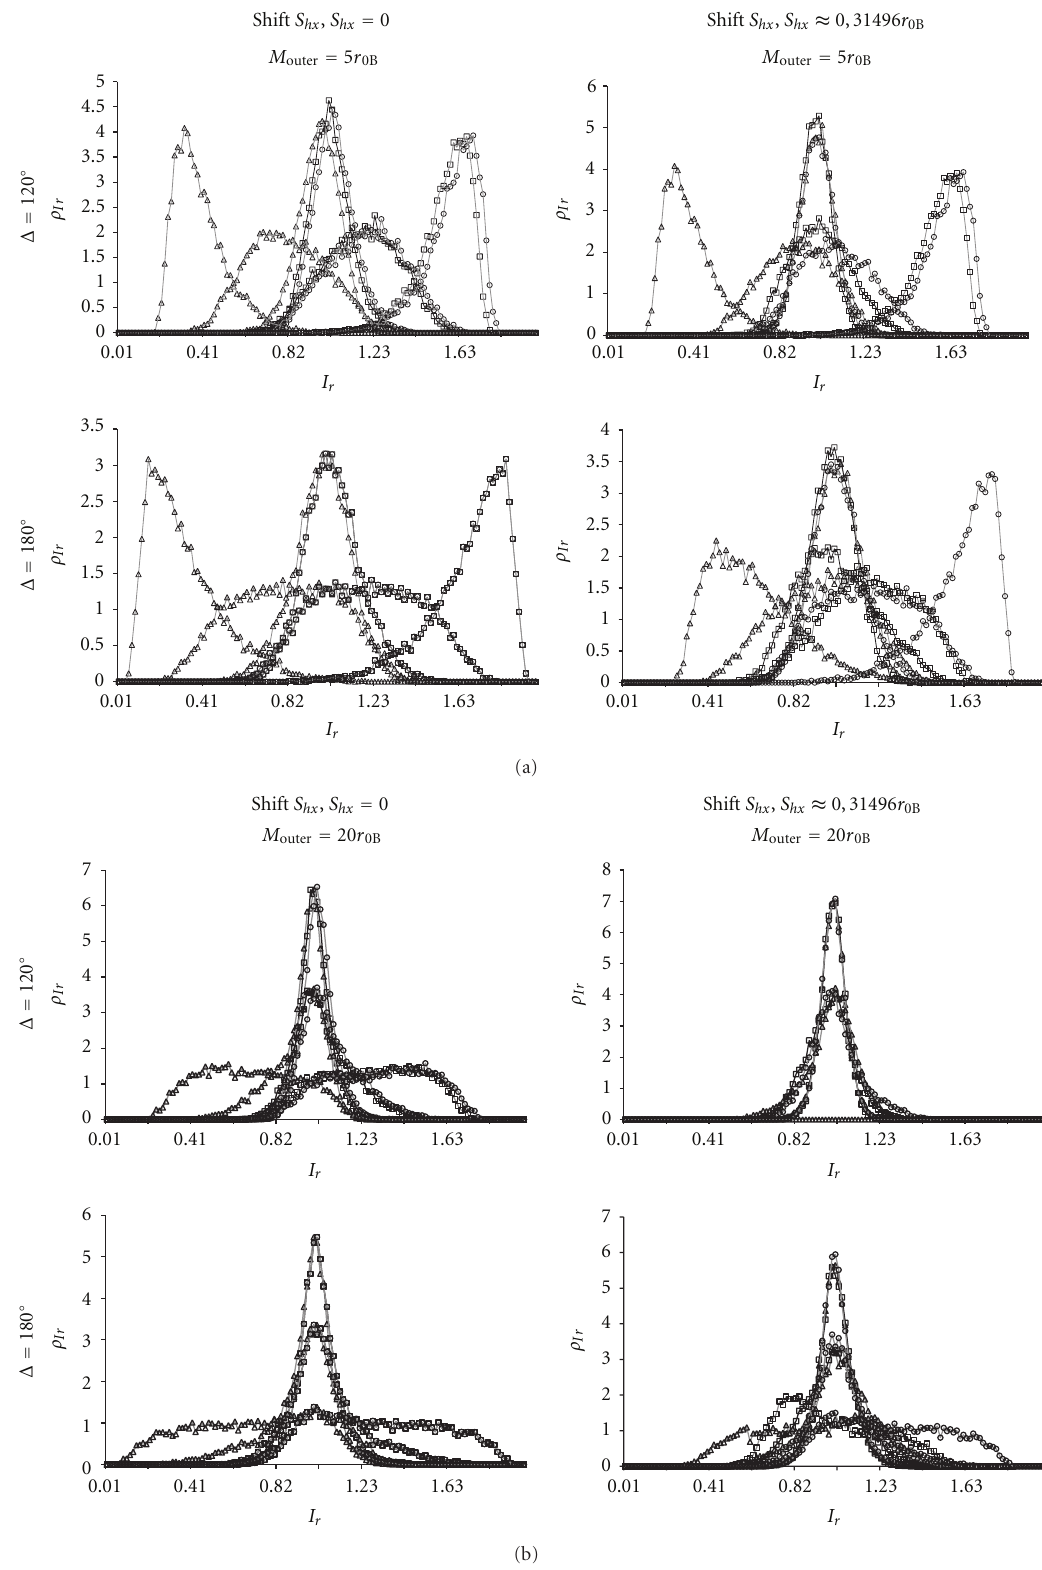
Figure 8: One-dimensional distributions of probability density ρ Ir ≡ ρ ( I r ) obtained with di ff erent values of M outer and S hx . The values of Fried’s coherence length are 0.25, 0.1, and 0.05. Curves marked by symbols “ Δ ”, “ (cid:2) ”, and “o” were obtained for topological charges − 1, − 2, and 0